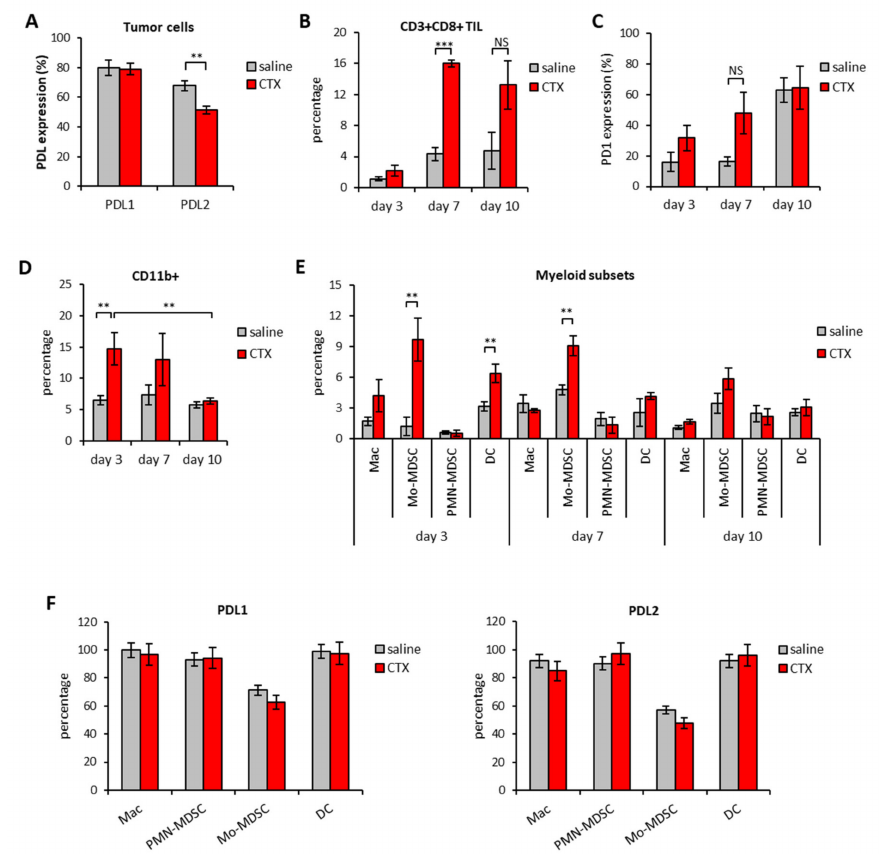
Figure 2. Modulation of PD1 / PDL molecules in the tumor of mice treated with CTX. C57Bl / 6 mice were treated with 100 mg / kg of CTX or with saline as control ( n = 5). Tumor mass were excised 3, 7, and 10 days after treatment and the leucocyte subset composition as well as the expression of PD1, PDL1 and PDL2 molecules was evaluated by multicolor flow cytomtery at each time point. (A) Ex-vivo expression of PDL1 and PDL2 on tumor cells 3 days after CTX administration ( n = 5). (B) Percentage of CD3 + CD8 + TIL and (C) PD1 expression at di ff erent time points from CTX or saline injection ( n = 5). Expression was analyzed after gating on viable FSC low SSC low